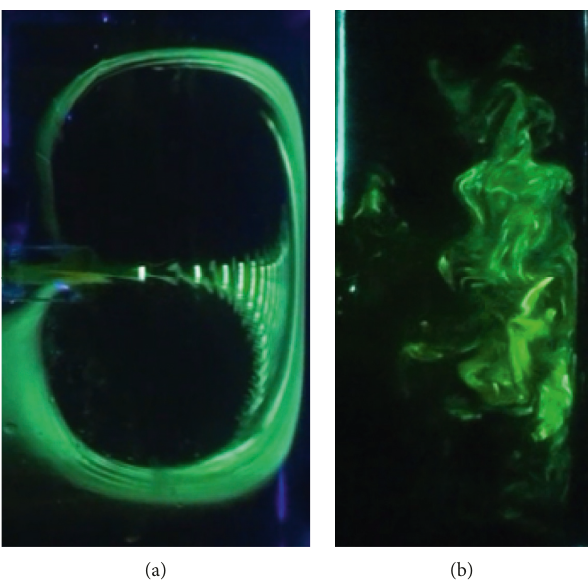
Figure 3: Streak line patterns of a paddle impeller at Re � 10 (a) and Re � 2,600 (b).